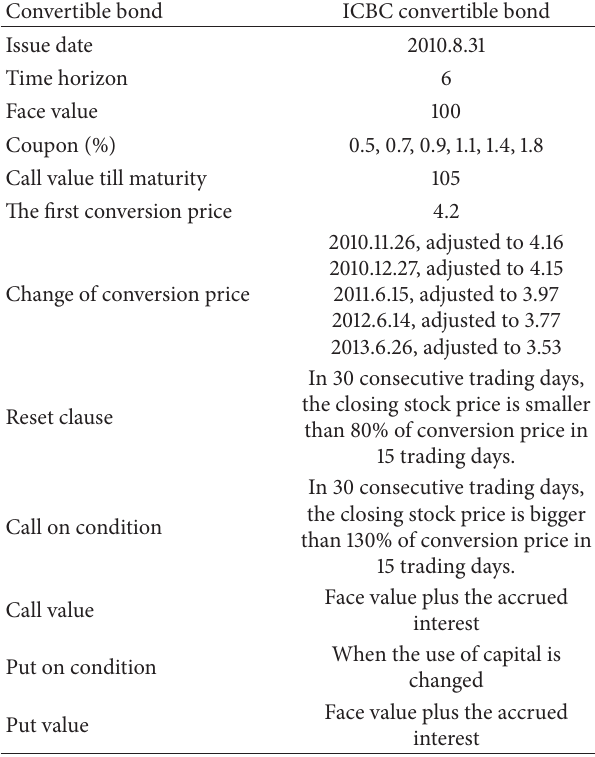
Table 2: ICBC convertible